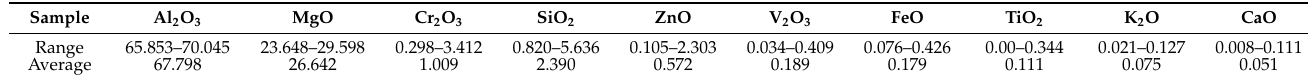
Table 1. EDXR F data of ‘Jedi’ spinel from Man Sin (weight%).